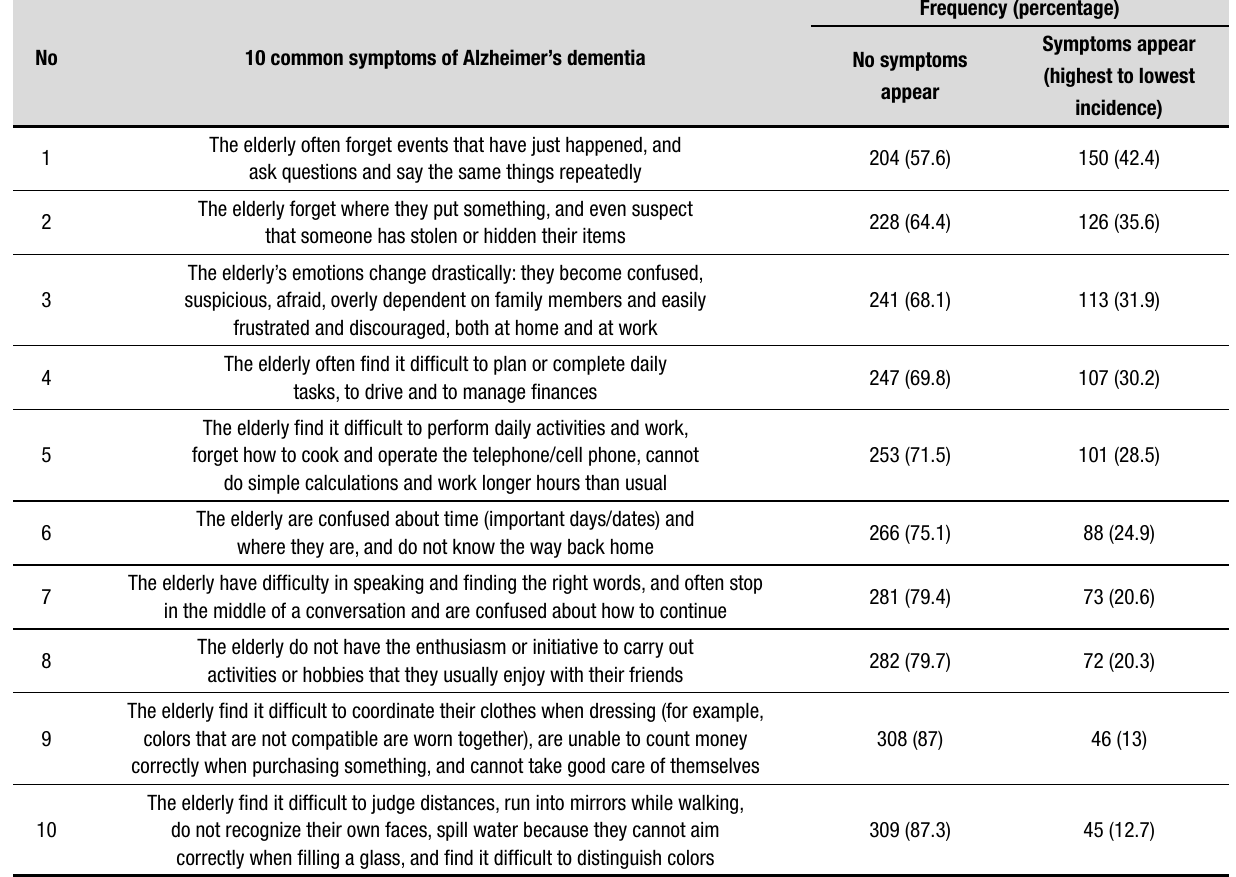
Table 3. Frequency distribution of 10 common symptoms of Alzheimer’s dementia in the elderly by family.